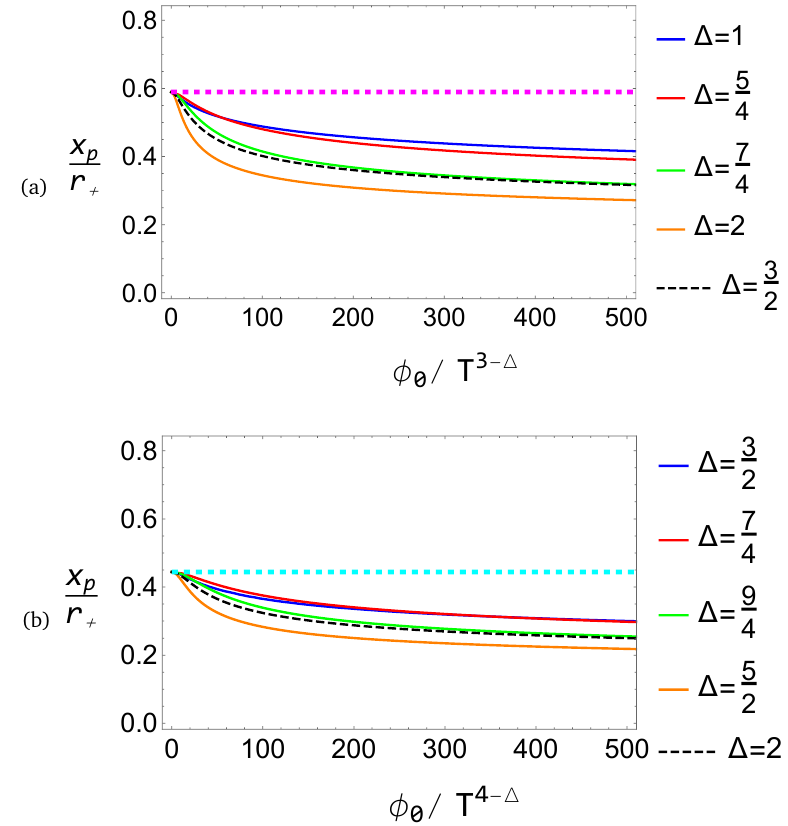
/ T d − ∆ for (a) d = 3 and (b) d = 4 as a function of φ p 0 / T d − ∆ 0